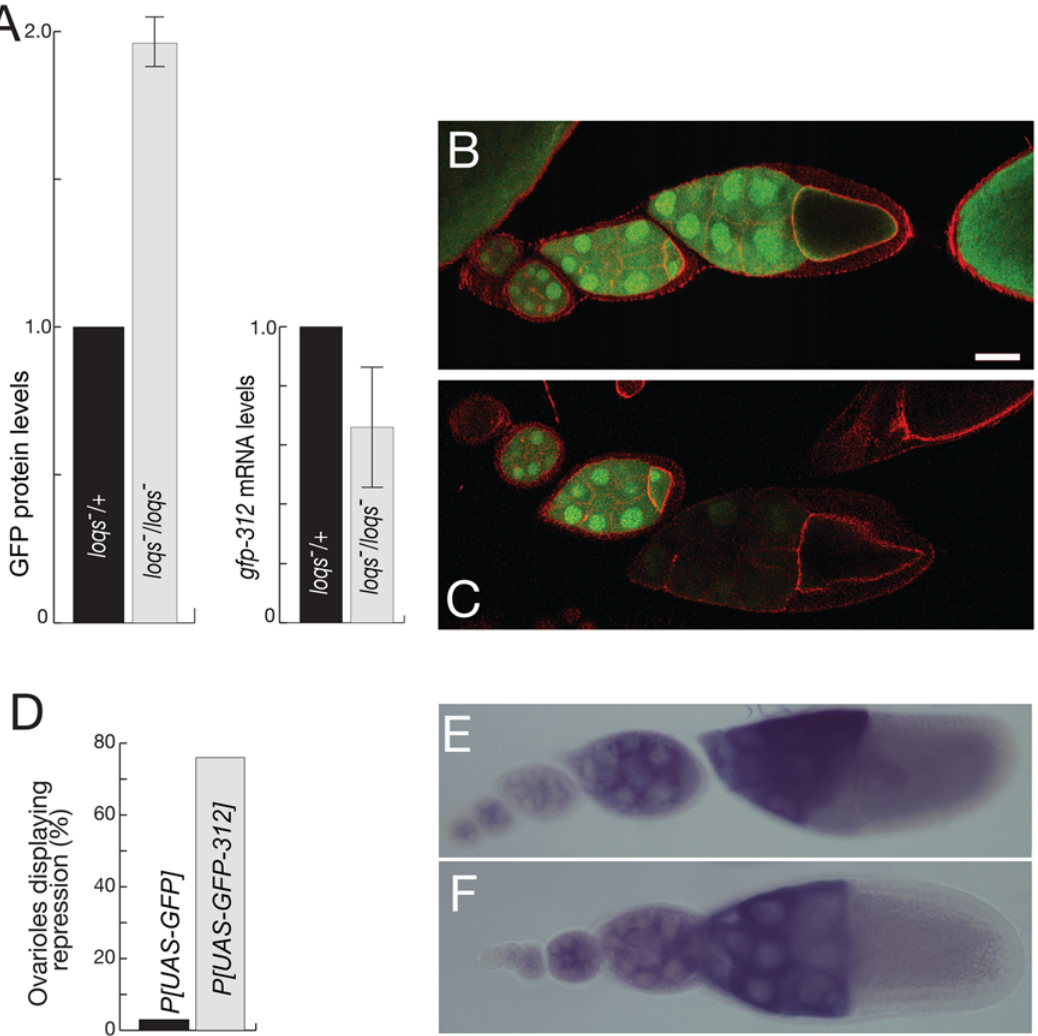
Figure 2. Translational repression of GFP-312 mRNA requires miRNA production. A. Quantitation of protein and mRNA levels from the UAS- GFP-312 transgene in females heterozygous or homozygous for loqs f00791 . Levels were determined as in Figure 1. B and C. GFP in ovarioles expressing the UAS-GFP (B) or UAS-GFP-312 (C) transgenes. GFP is in green, and phalloidin staining in red. GFP signal intensity at early stages of oogenesis (to the left in the panels) is typically lower for the UAS-GFP-312 transgene, but was adjusted to show a similar intensity as for UAS-GFP at those stages; this better reveals the extent of the difference between GFP levels for the two transgenes at later stages of oogenesis (at right). D. Quantitation of early/ late stage GFP levels in individual ovarioles. Fluorescence intensity was measured in stage 7 or 8 and 10 egg chambers of individual ovarioles. If the ratio of fluorescence in stage 7/8 to stage 10 was greater than 1.5, then the ovariole was considered to show repression. E and F. In situ hybridization detection of GFP (E) and GFP-312 (F)